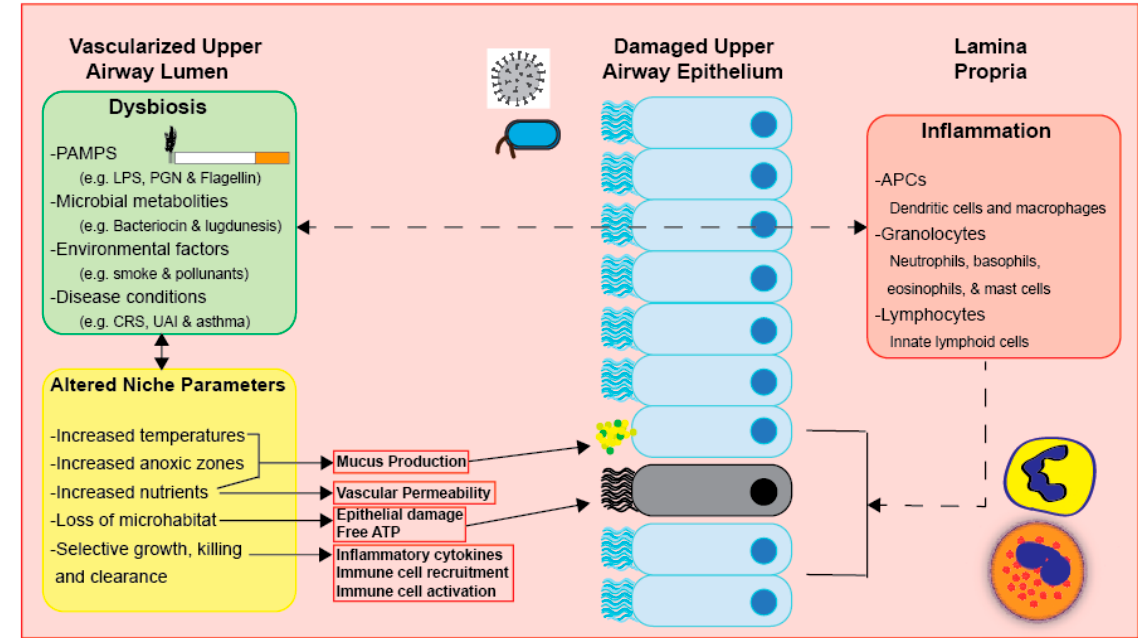
Figure 3. Dysbiosis, inflammation, and altered niche parameters heavily impact respiratory physiology. These three factors are at continuous interplay. However, the direct mechanisms that may further elucidate this three-way relationship have not been defined.